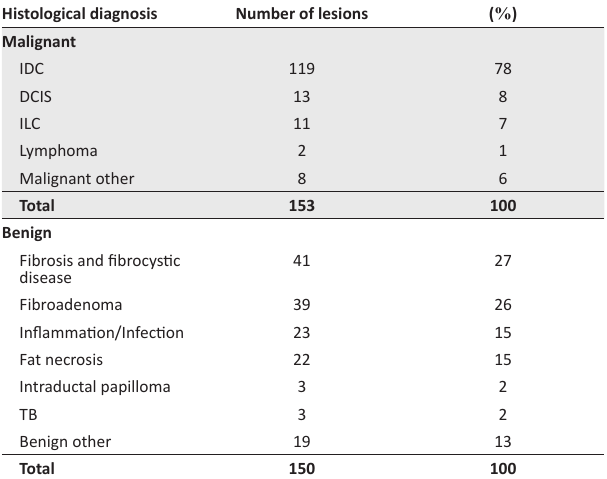
FIGURE 2: Summary of the results of the lesions biopsied in this TABLE 1: Malignant and benign histological diagnoses of the ultrasound-guided core-needle breast biopsies performed during the study. Histological diagnosis